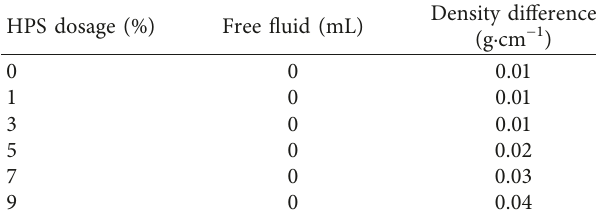
Table 4: Effect of HPS dosage on the stability of cement slurry.